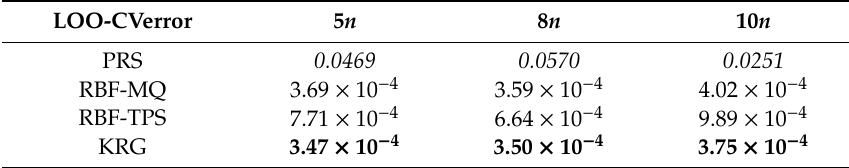
Table 13. Results of LOO-CVerror of four surrogate